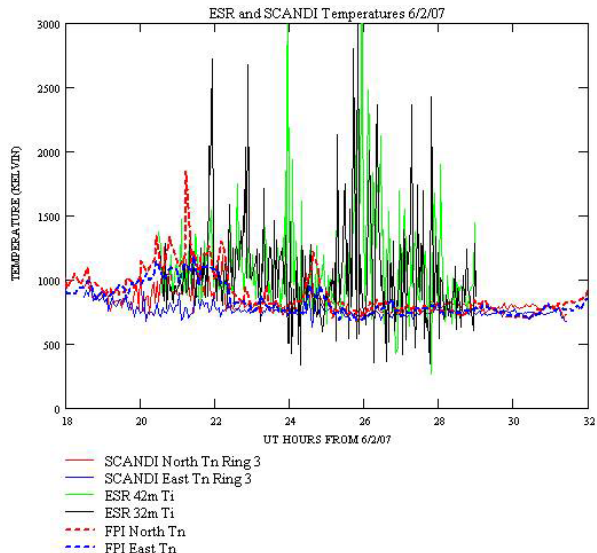
Fig. 17. Comparison of ion temperatures observed by the 2 ESR radars with the neutral temperatures observed by SCANDI on the night of 6–7 February